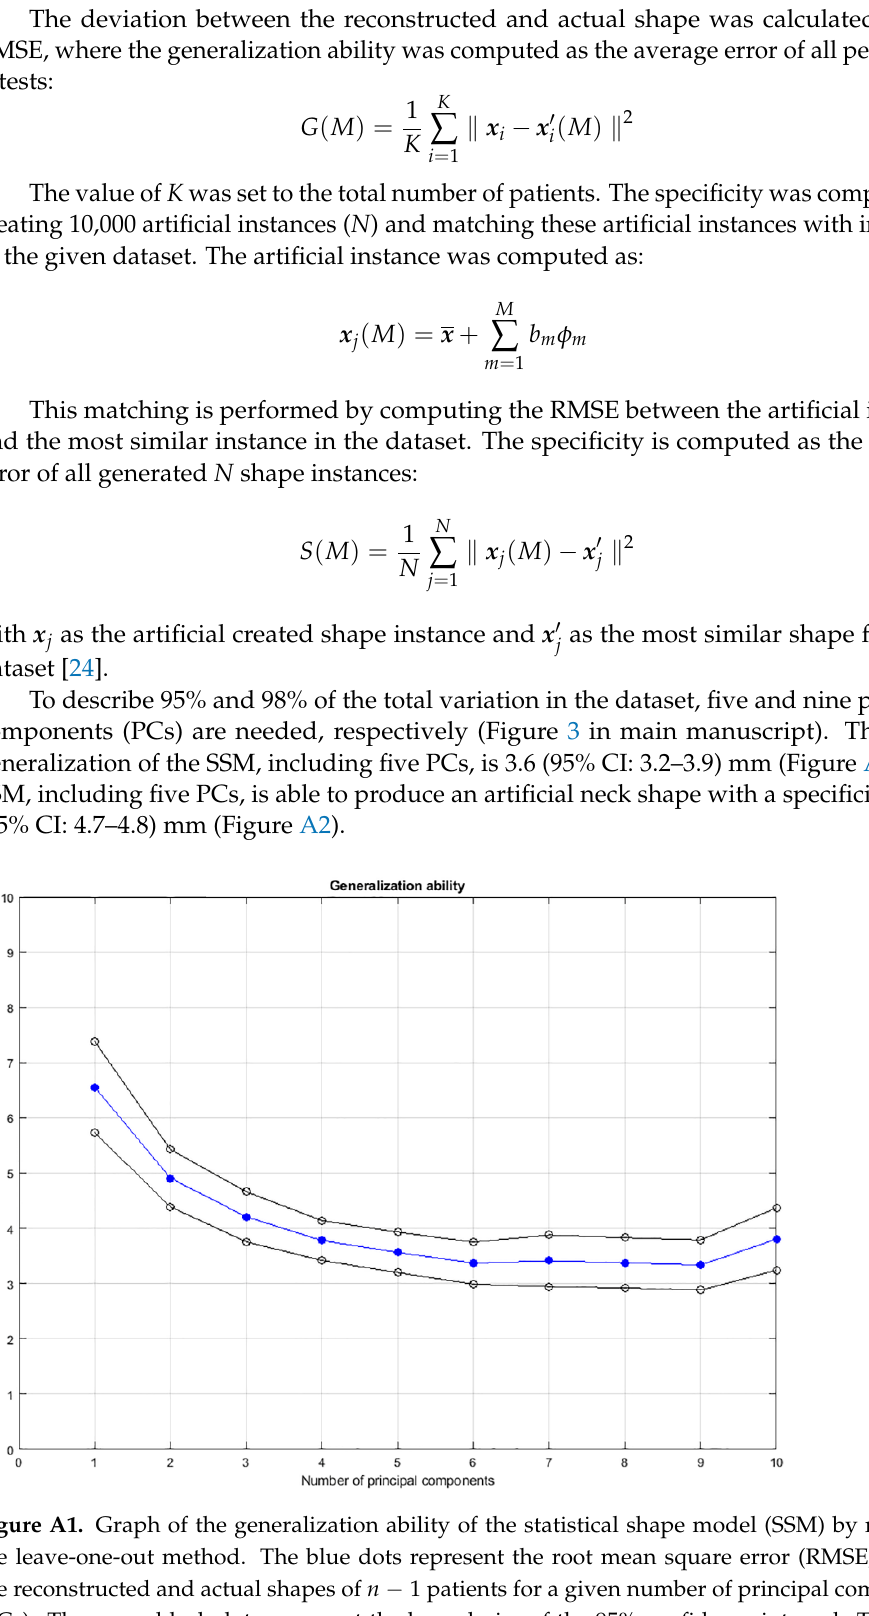
Figure A2. Graph of the specificity of the statistical shape model (SSM); mean specificity and the 95% confidence intervals are given. The mean specificity for five principal components (PCs) is 4.8 (95% CI: 4.7–4.8) mm.